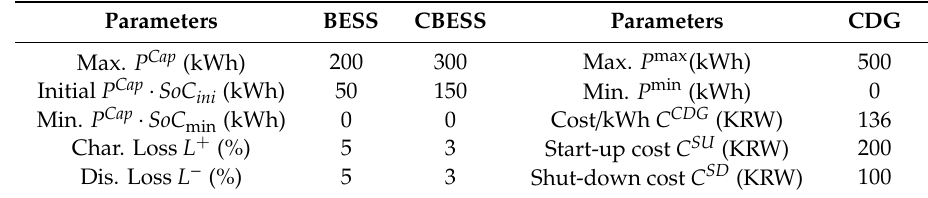
Figure 5. Input data: ( a ) market price signals and load profile; ( b ) output power of the renewable distributed generator (RDG). Table 1. The detail parameters of BESS, CBESS, and controllable distributed generator (CDG).